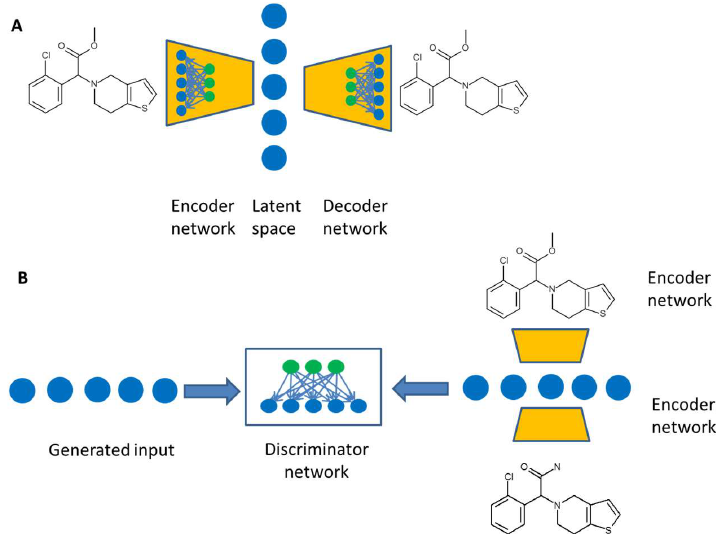
Figure 4. ( A ) A variational autoencoder consists of two neural networks. The encoder network transforms the molecular description into a description vector, the latent space, while the decoder network is trained to translate a latent space vector into a molecule. ( B ) The adversarial autoencoder comprises a standard autoencoder, which learns to generate chemical structures. The discriminator network compares descriptions from a defined distribution to structures generated from the autoencoder.